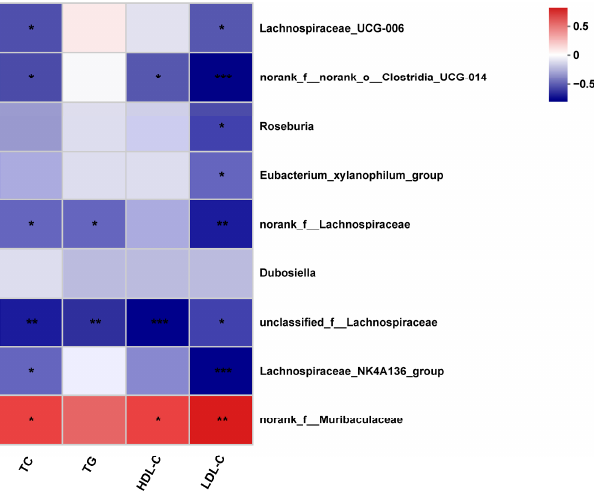
Figure 4. Spearman’s correlation analysis between serum TC, TG, HDL-C, LDL-C and gut microbi- ota taxa in the control, model, cytidine and uridine groups. * p < 0.05, ** p < 0.01, *** p <